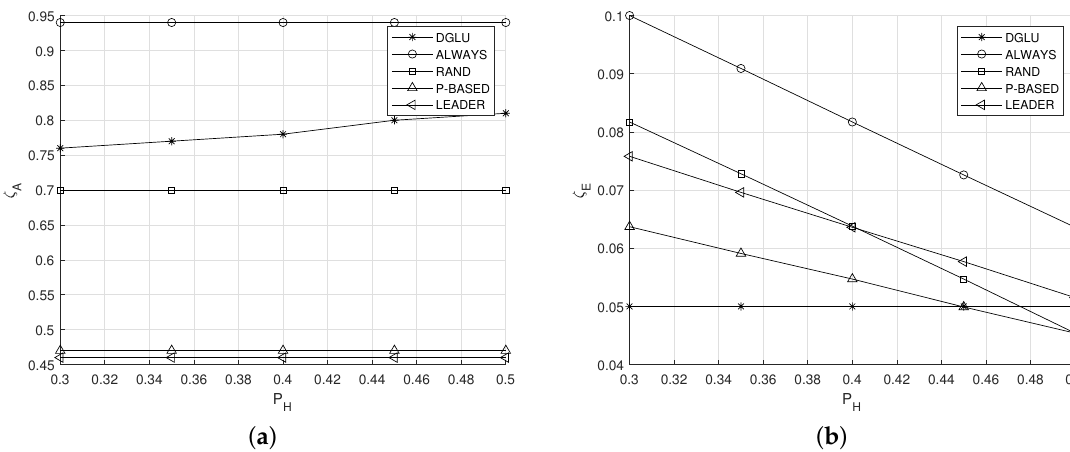
Figure 6. Effect of the energy harvesting probability P H . ( a ) Average location accuracy ζ A . ( b ) Average energy outage probability ζ E .